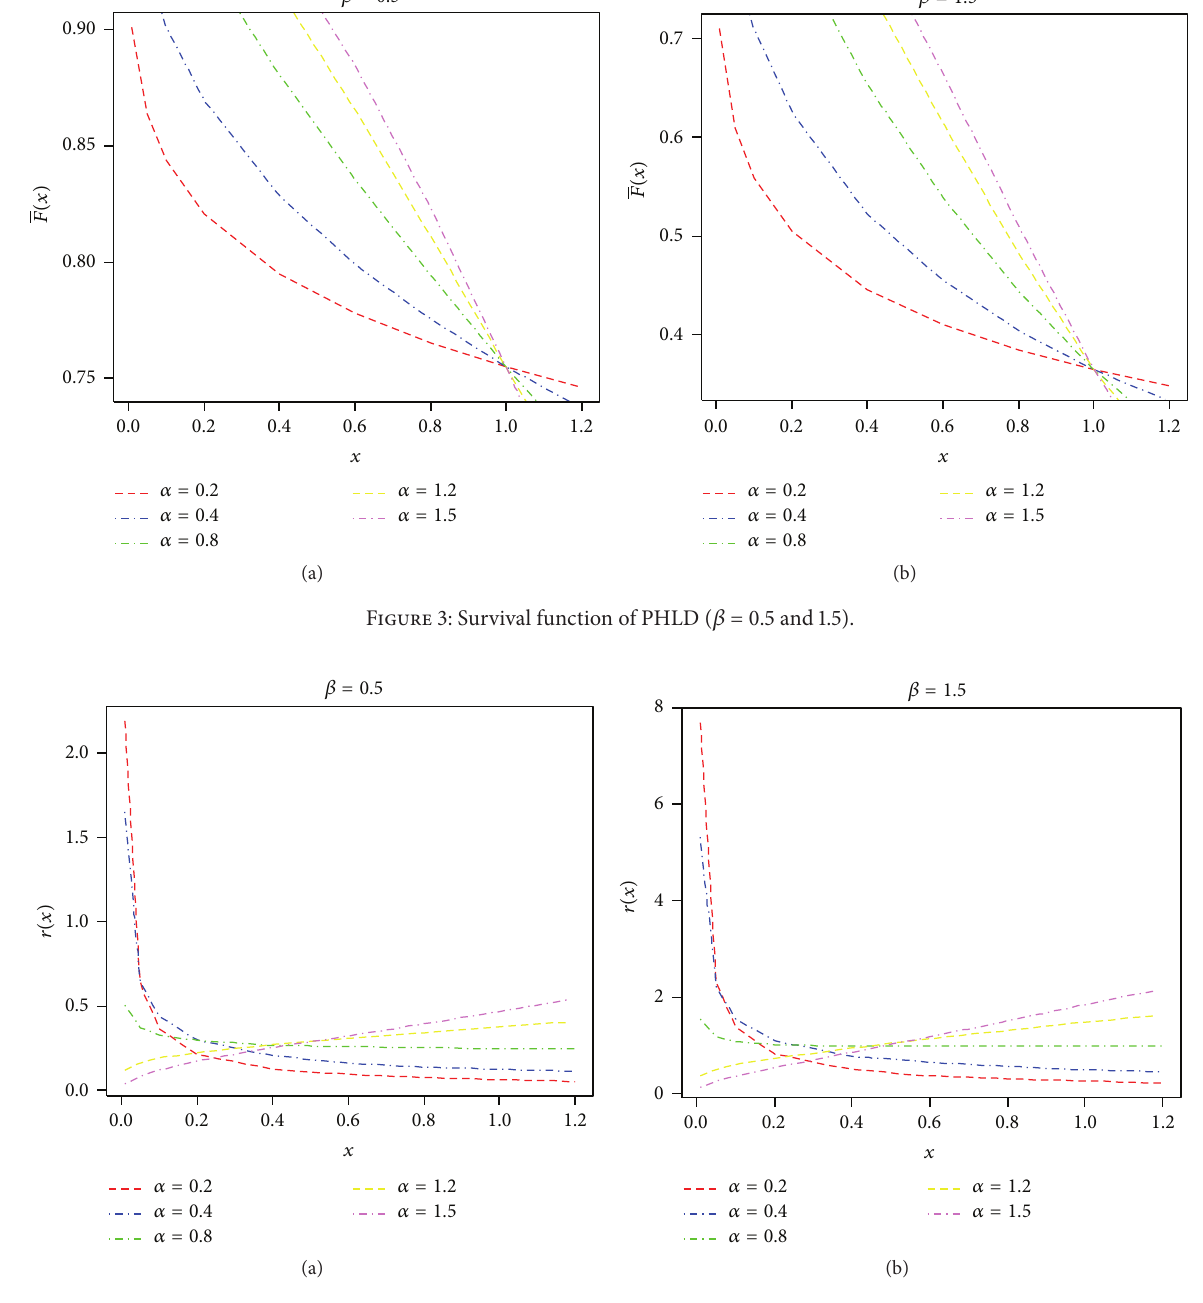
Figure 4: Hazard rate of PHLD ( 𝛽 = 0.5 and